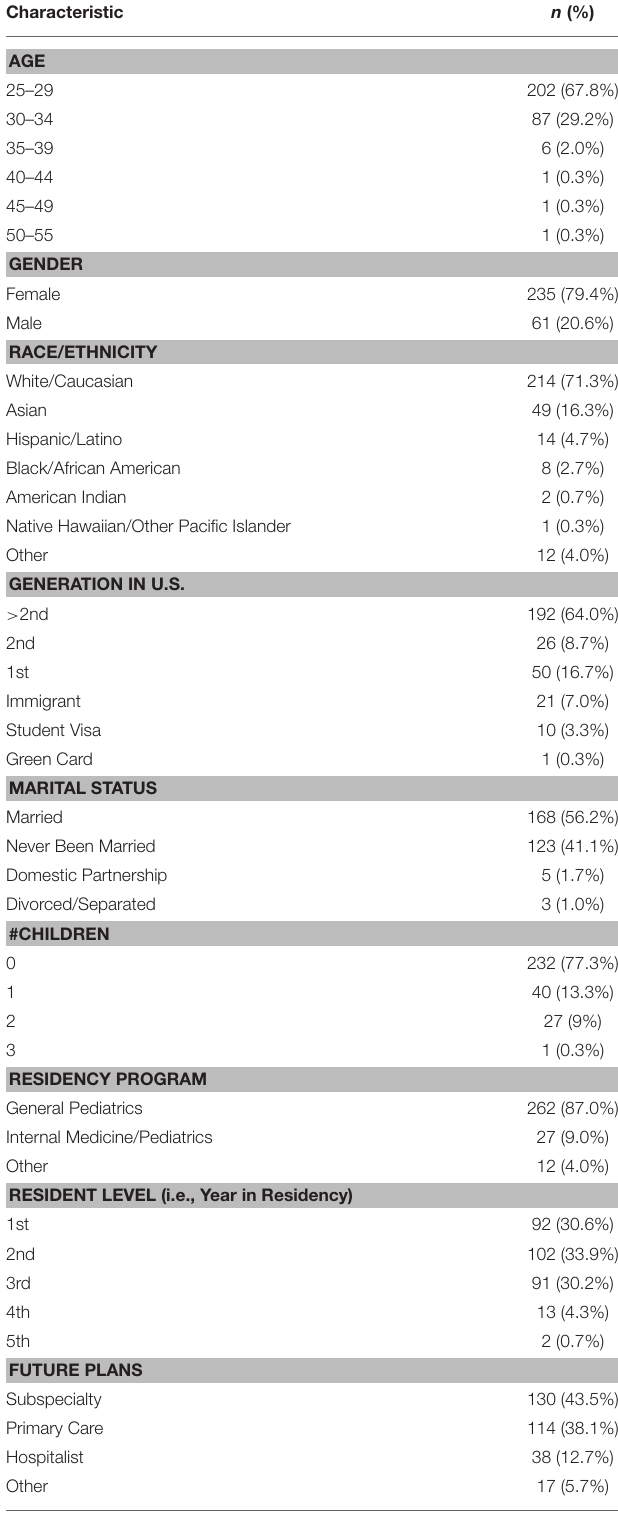
TABLE 2 | Resident parenting questionnaire participant sample demographics ( N = 301) a .